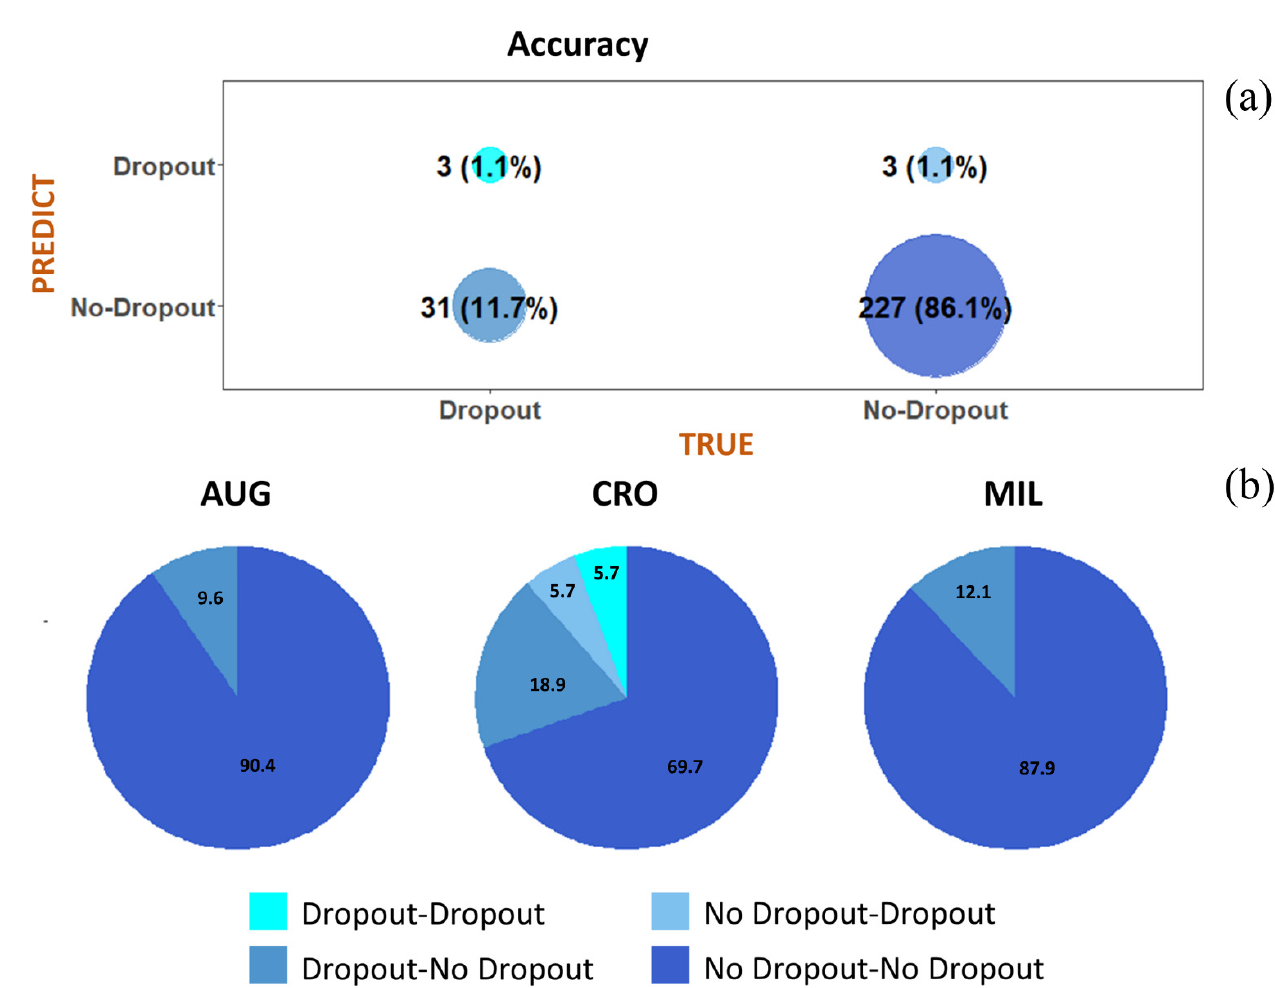
Figure 6. Confusion matrix to describe the performance of the neural network classifier model for total testing sample and within each evaluated site. ( a ) Confusion matrix including the number of true and false positive/negative dropouts generated by the network; ( b ) confusion matrix for each National Priority Contaminated Site.